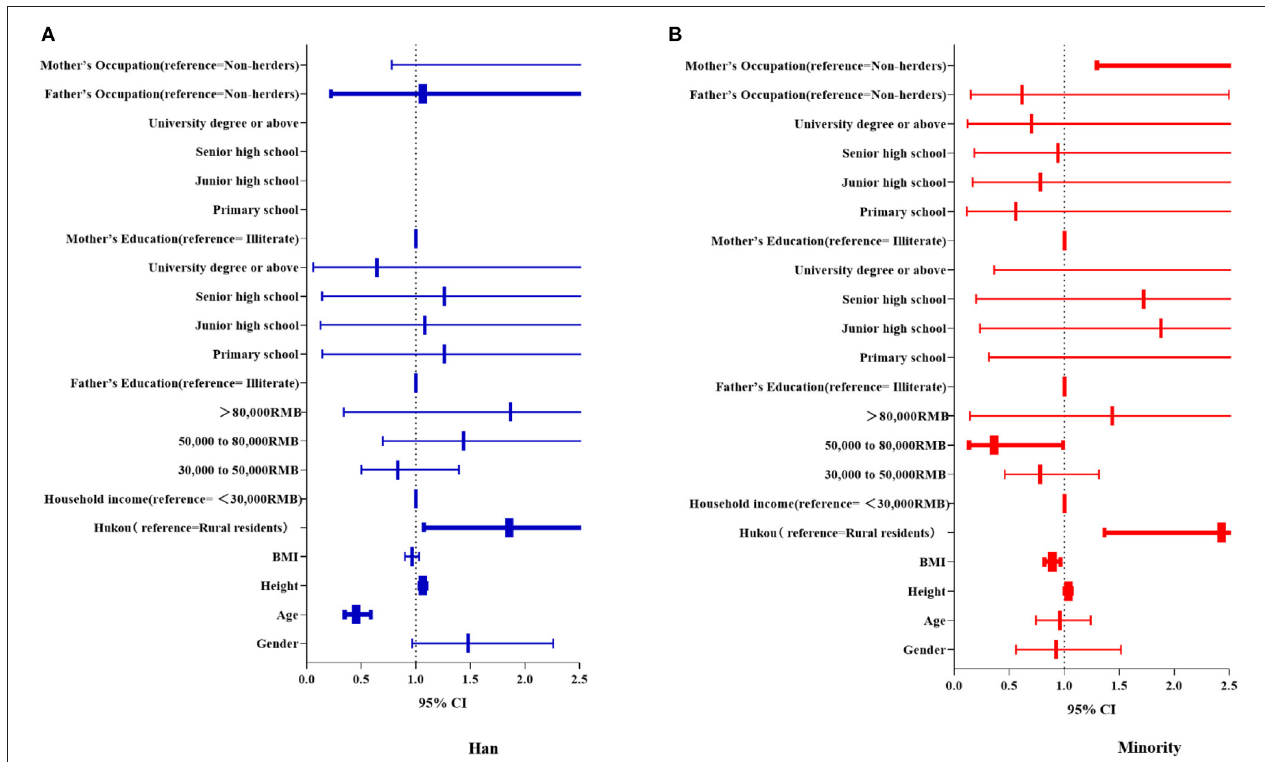
FIGURE 5 | Forest map comparing differences in the influence of various factors on scoliosis between the two groups. Bold font indicates statistically significant variables. Sex, age, height, BMI, and SES-related factors were independent variables, and ATR value ≥ 5 ◦ was the dependent variable in the logistics regression model of (A) Han and (B) ethnic minority groups. BMI, body mass index; SES, socioeconomic status; ATR, angle of trunk rotation; CI, confidence